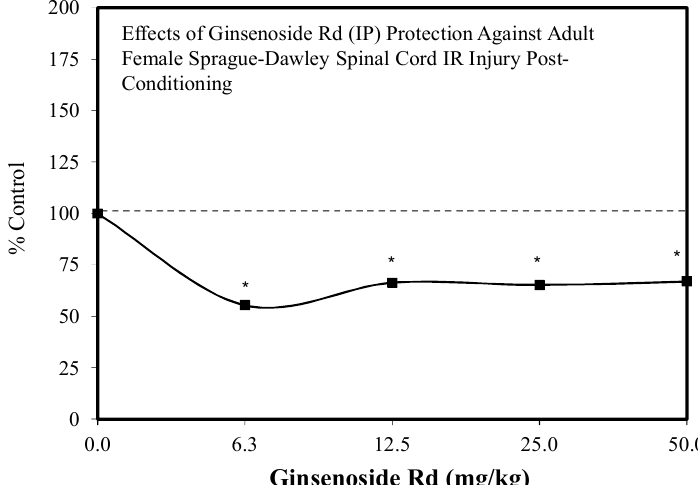
Figure 28. Effects of ginsenoside Rd pretreatment (i.e., measured by cell viability: 2 h) on glutamate toxicity to HT22 mouse hippocampal neuronal cells (source: [106]). Each * represent statistical significance for a data point.